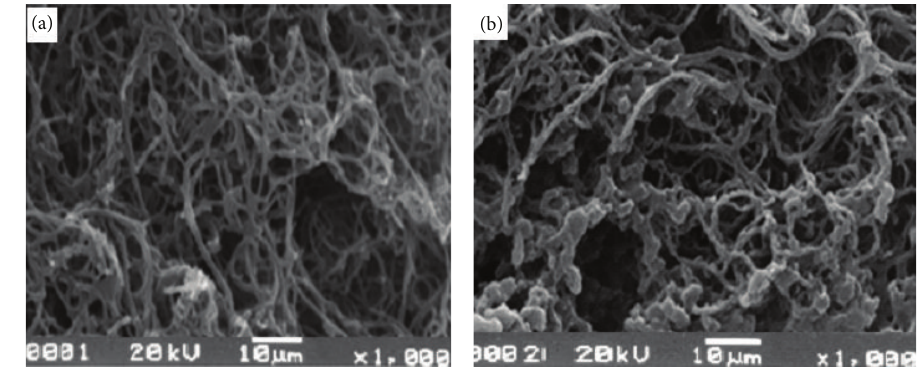
Figure 3: SEM of (a) raw MWCNTs and (b) f-MWCNTs.